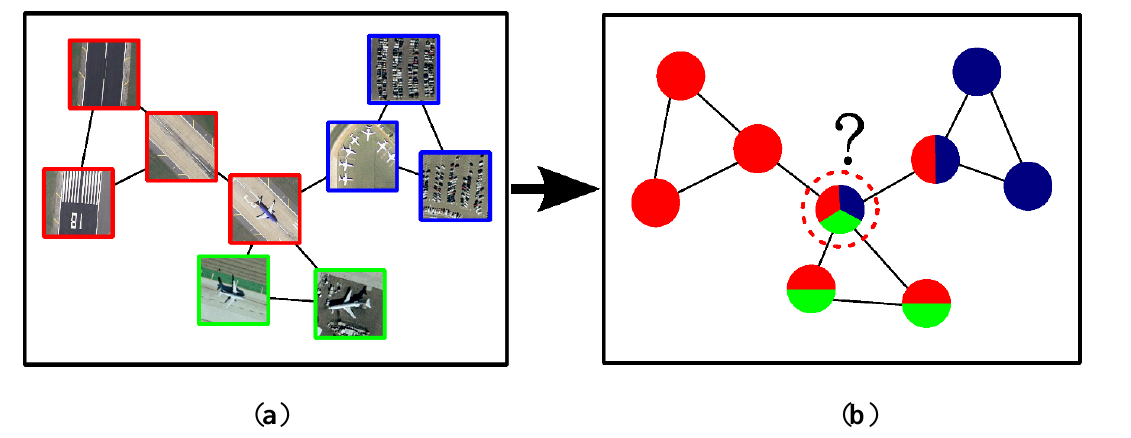
Figure 3. Active constraint selection process: selection of the most uncertain node based on the current k -NN graph and the clustering result. ( a ) The current k -NN graph, in which different clustering labels are represented by differently colored frames. ( b ) The selection of the most uncertain